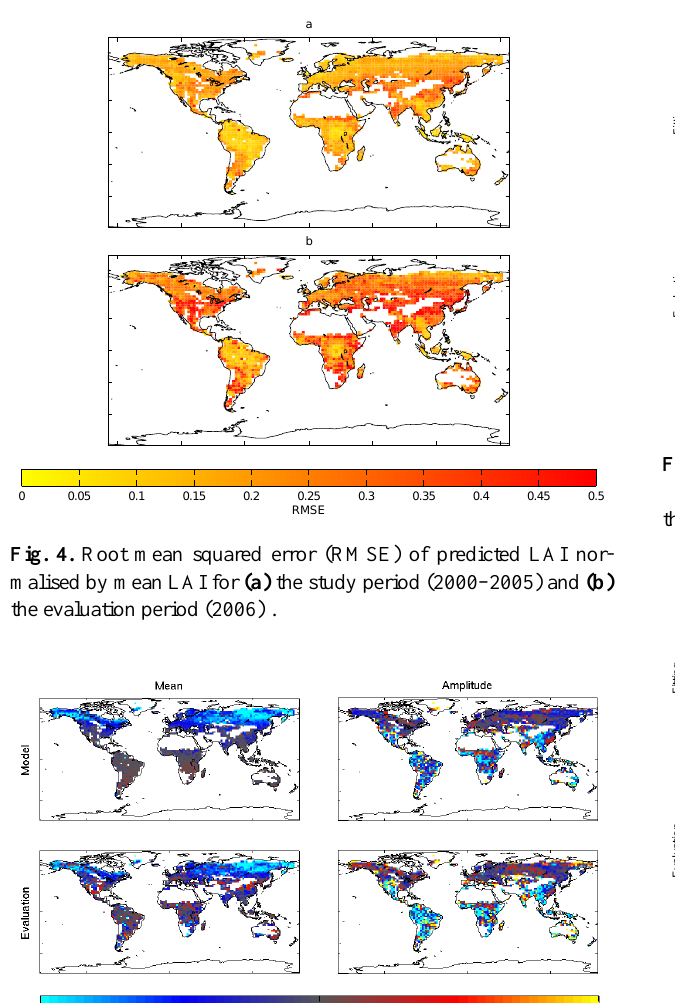
Fig. 7. As for Fig. 6 but for seasonal